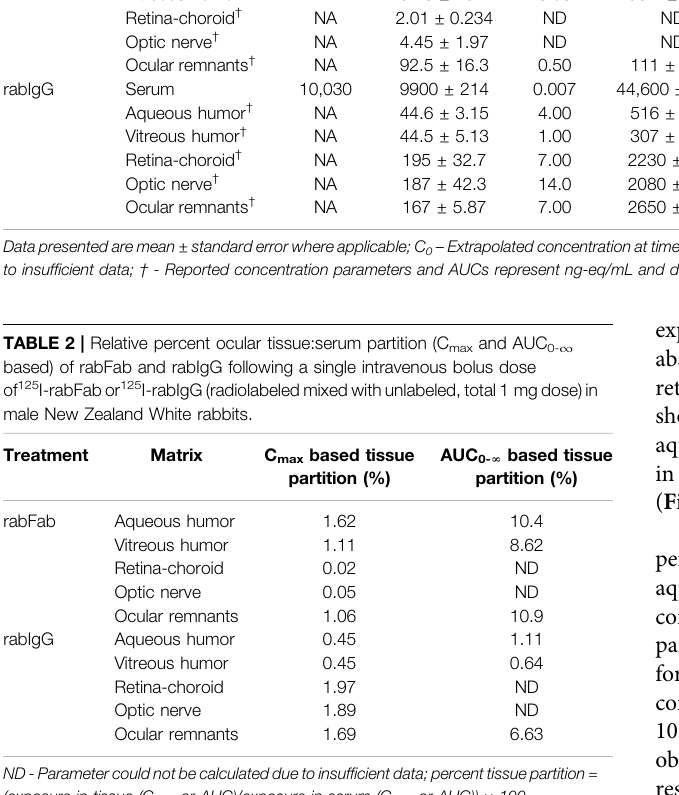
TABLE 1 | Non-compartmental pharmacokinetic parameters of rabFab and rabIgG in serum and ocular compartments following a single intravenous bolus dose of 125 I-rabFab or 125 I-rabIgG (radiolabeled mixed with unlabeled, total 1 mg dose) in male New Zealand White rabbits. Treatment Matrix group